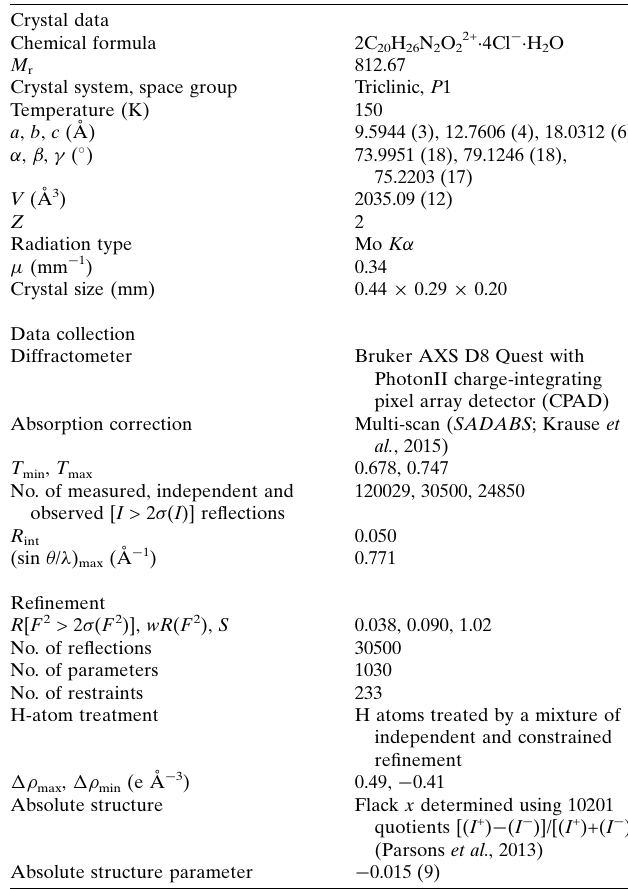
Table 1 Hydrogen-bond geometry (A˚ , (cid:5) ).